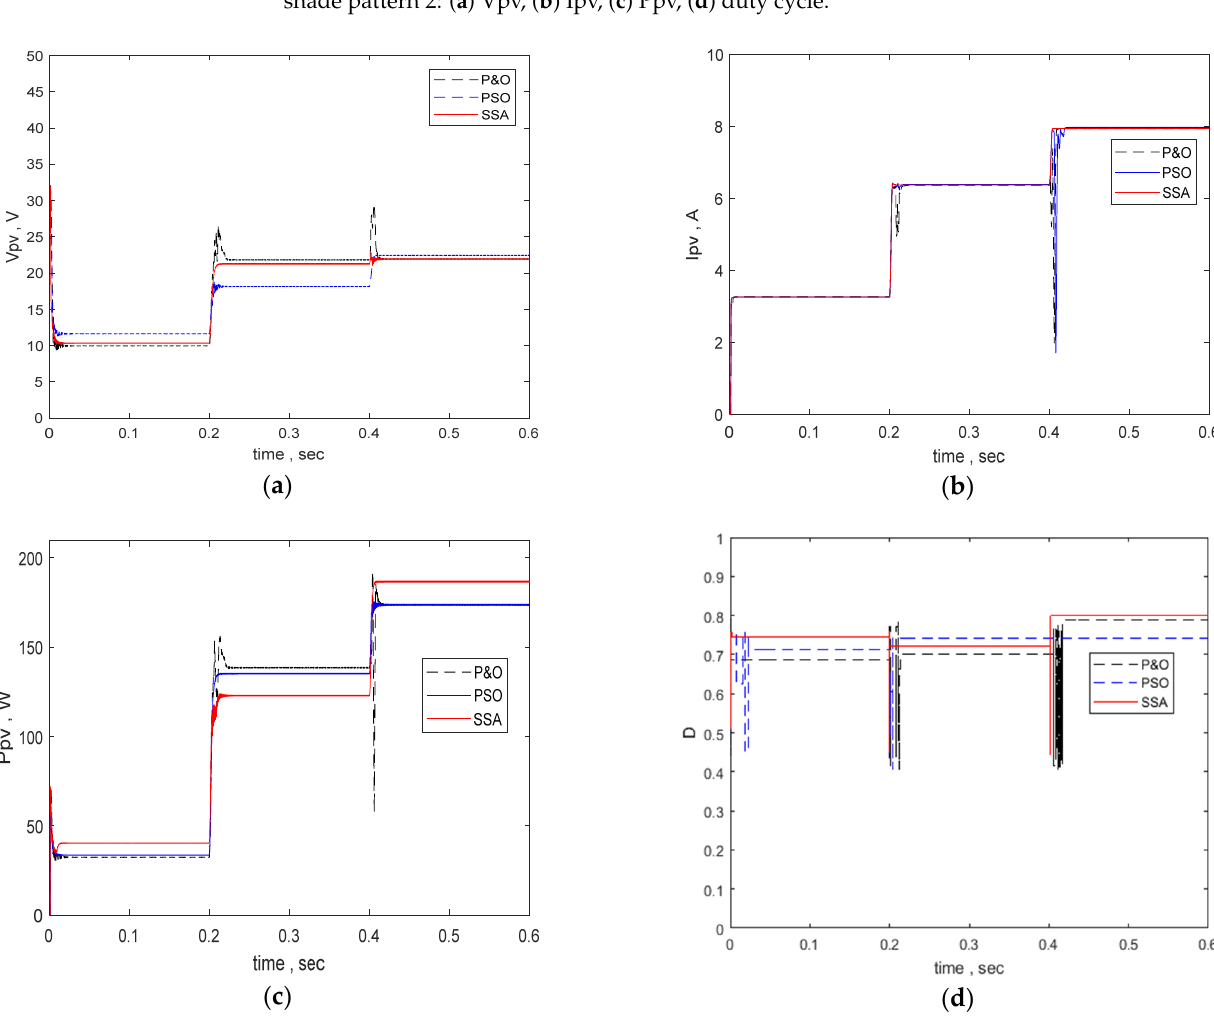
Figure 11. Photovoltaic panel tracking curves using P&O, PSO, and SSA methods in the condition of shade pattern 2: ( a ) Vpv, ( b ) Ipv, ( c ) Ppv, ( d ) duty cycle.